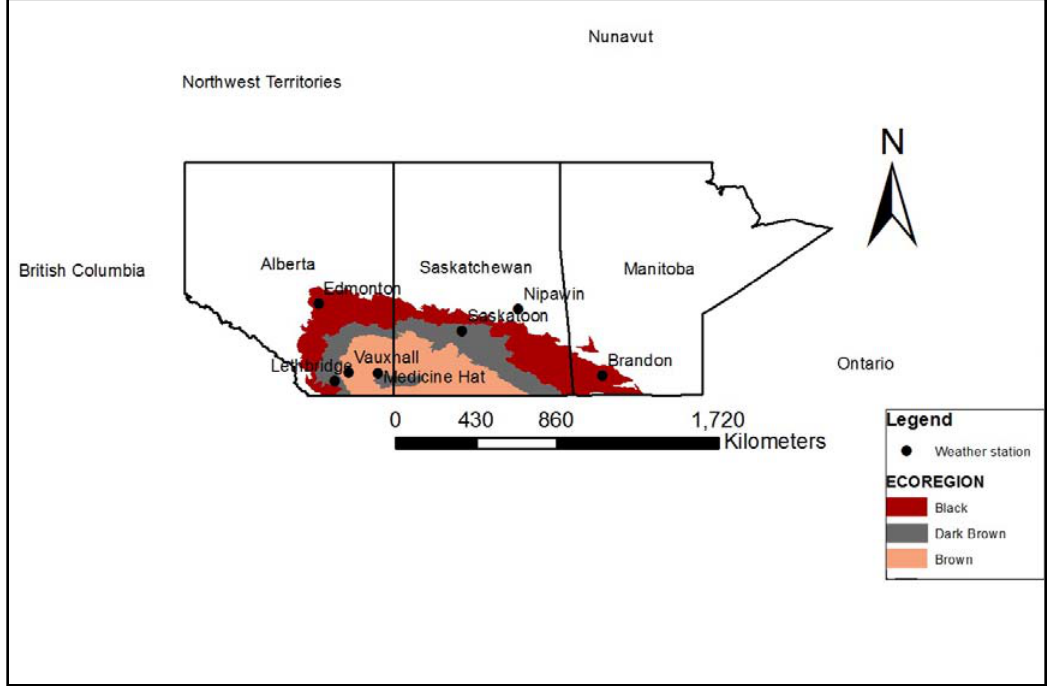
Figure 1. Map of the study area showing the three major soil zones with representative weather stations.